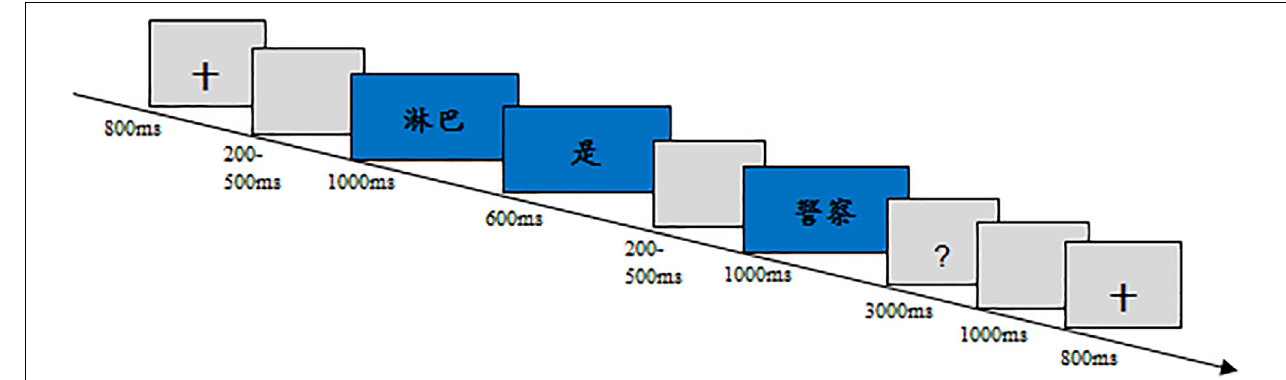
FIGURE 1 | The procedure of Experiment